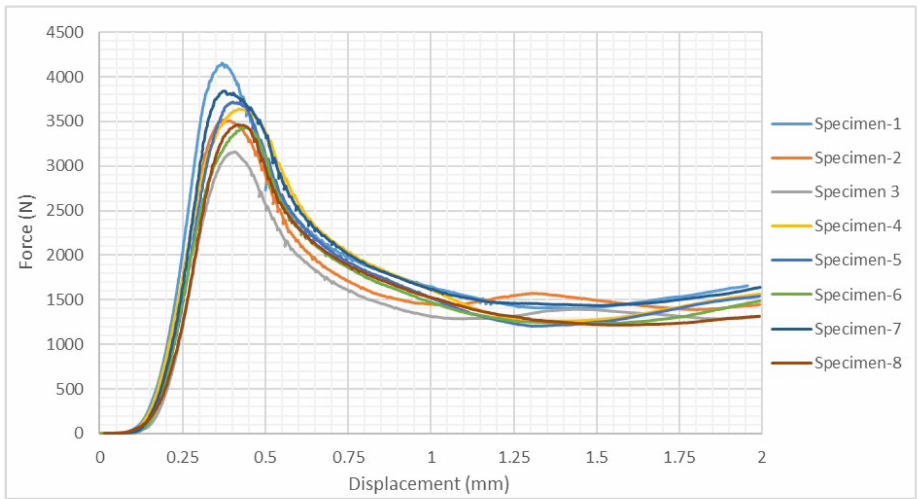
Figure 21. Force-displacement curves for the compression testing of the 5052 aluminum alloy honeycomb